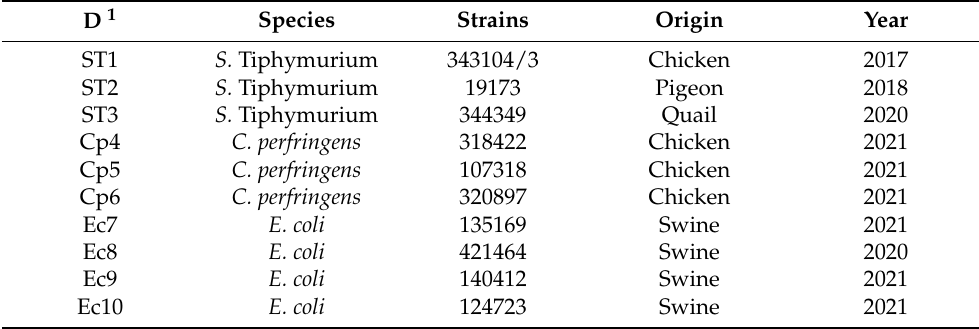
Table 1. Bacterial strains used in this